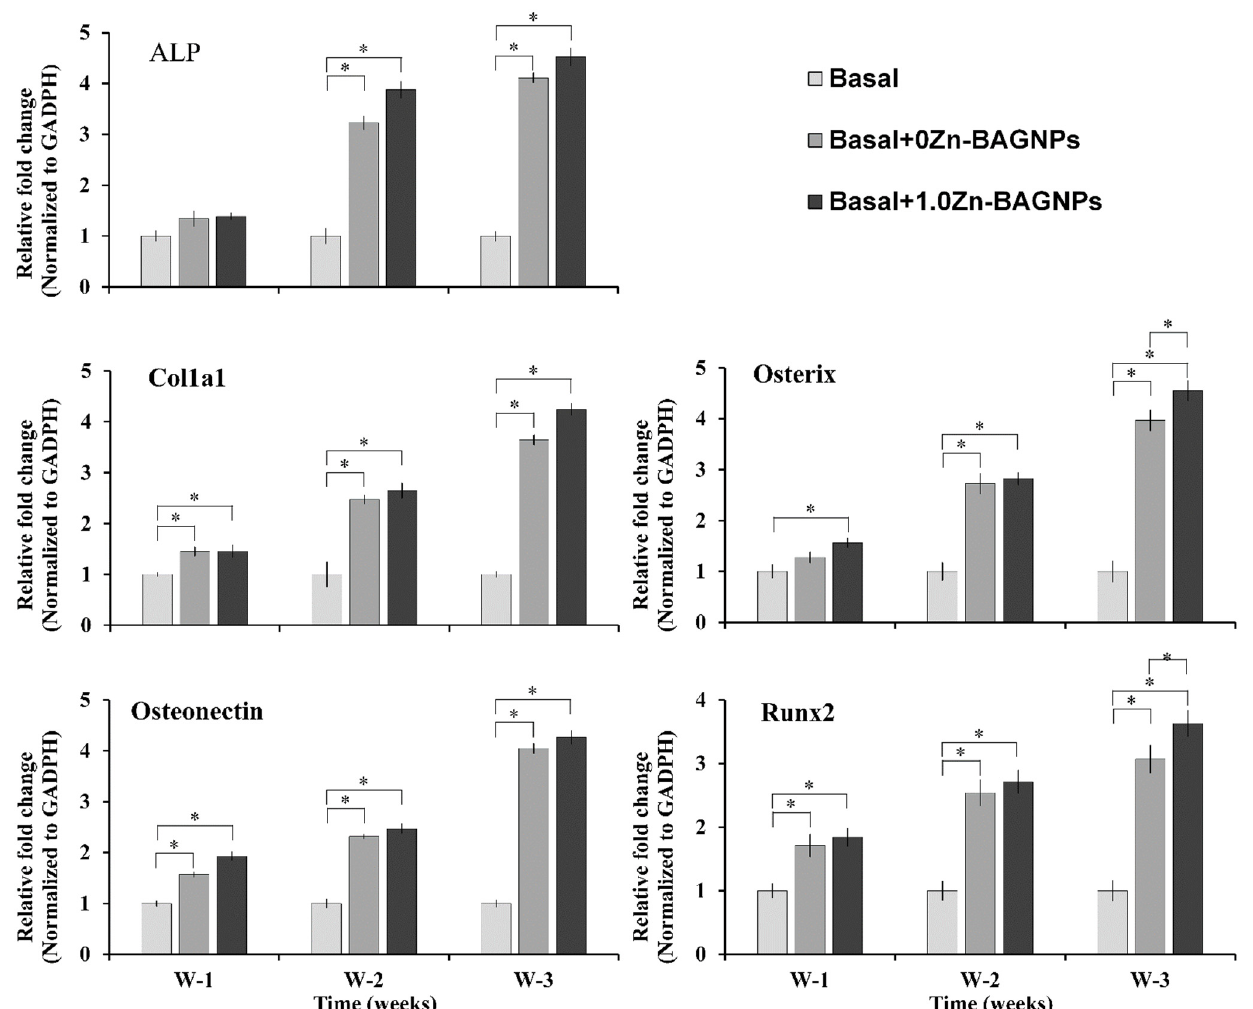
Figure 11. Quantitative real-time reverse transcriptase PCR analysis showing the expression of osteogenic marker genes in PDLSCs treated with Zn-BAGNPs, cultured under the basal condition for 1 week, 2 weeks, and 3 weeks. Gene expression was normalized to GAPDH (a housekeeping gene) transcript levels. The data represent two independent experiments. The values are the mean ± SD ( n = 3). The expression of osteogenic marker genes was significantly up-regulated in cells treated with particles compared to untreated cells. * above the bars represents a significant difference between treated PDLSCs versus untreated PDLSCs under the basal condition at the same time interval (* p < 0.05).